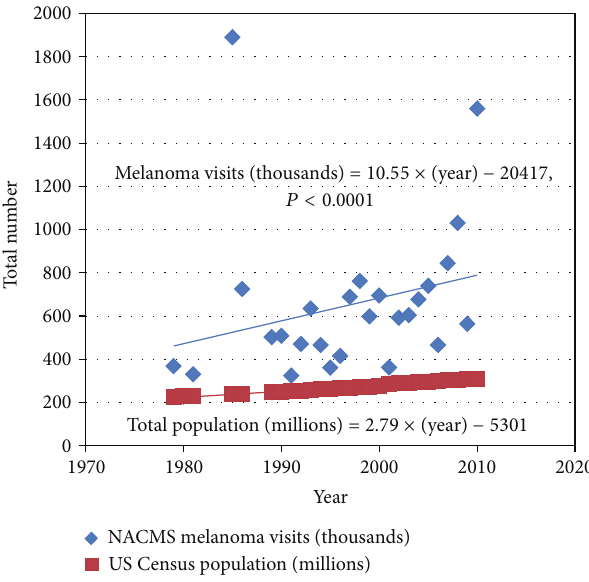
Figure 1: Estimated number of melanoma visits (thousands) from the US National Ambulatory Medical Care Survey (NACMS) from 1979 to 2010 compared to total US population